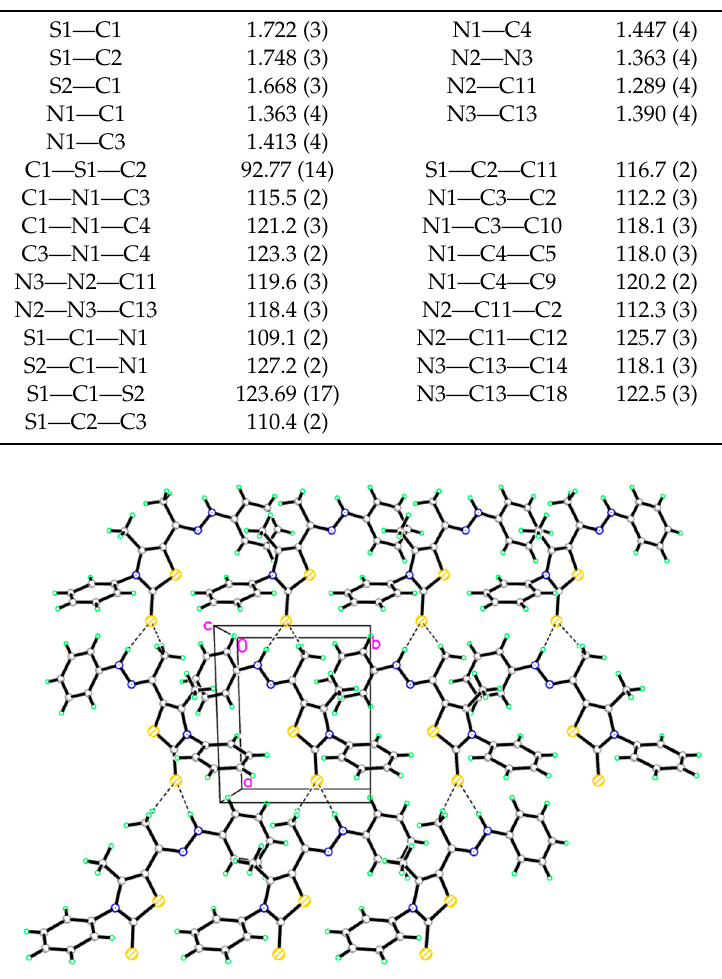
Table 2. Selected geometric parameters (Å) of thiazoline 5c .